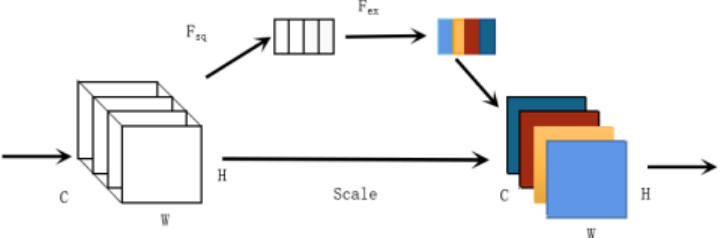
Figure 3. SE module architecture. Fsq represents the squeeze operation in the SE module. Fex represents the excitation operation in the SE module. Scale represents multiplying channel weights.